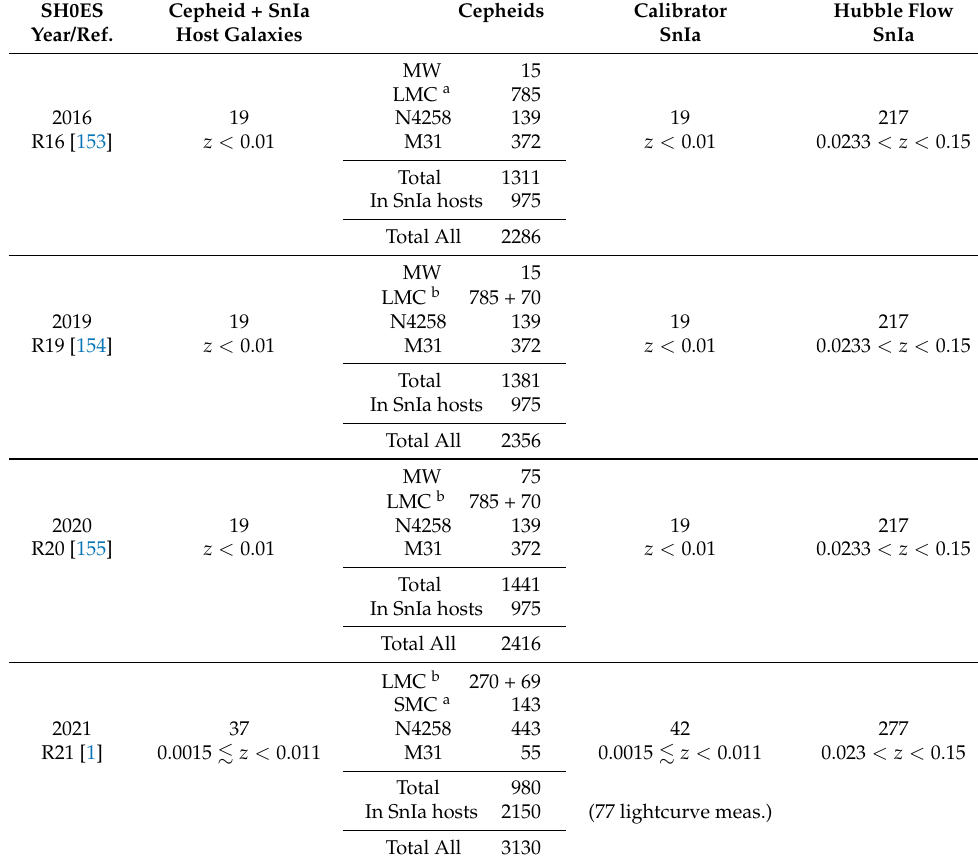
Table 1. A comparison of the latest SH0ES data release (R21) with previous data